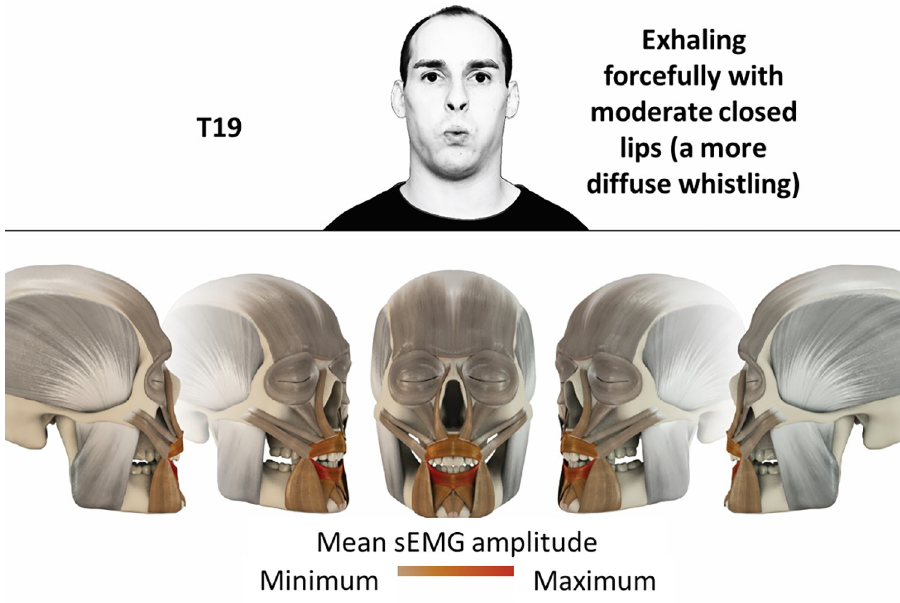
Fig 20. Color-coded facial muscle activation pattern of task T19. Exhaling forcefully with moderate closed lips. Animation by Jonas Laustro¨er.